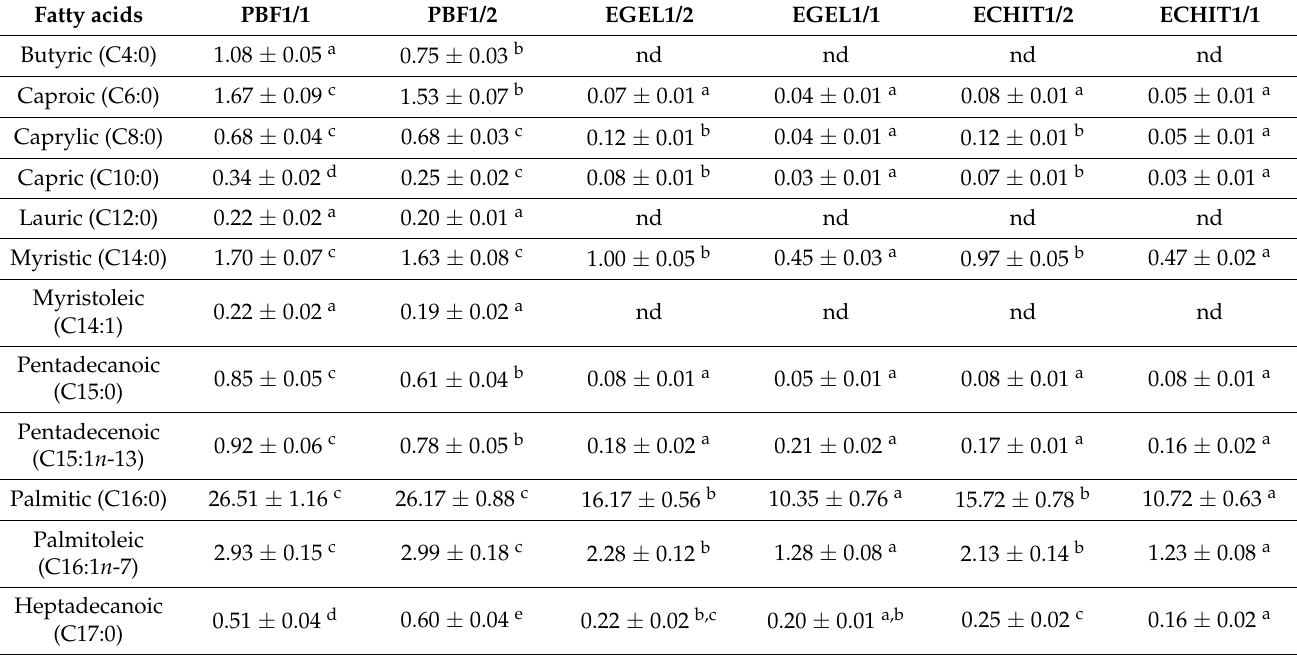
Table 4. Fatty acid profile (expressed as g/100 g of total fatty acids) and nutritional indices of control and reformulated pork patties